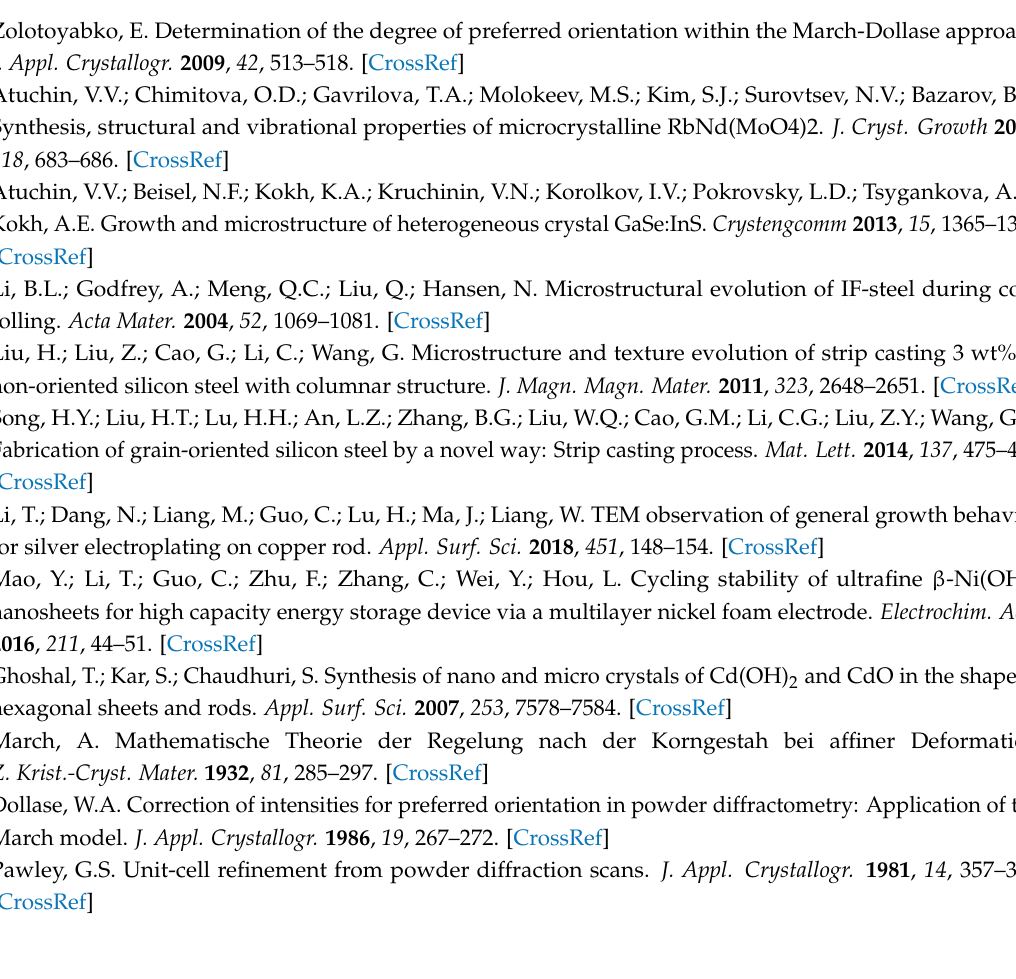
Figure S1: The simulated linear function with Halder-Wagner’s method. The Diameters of D 00l and D hk0 are